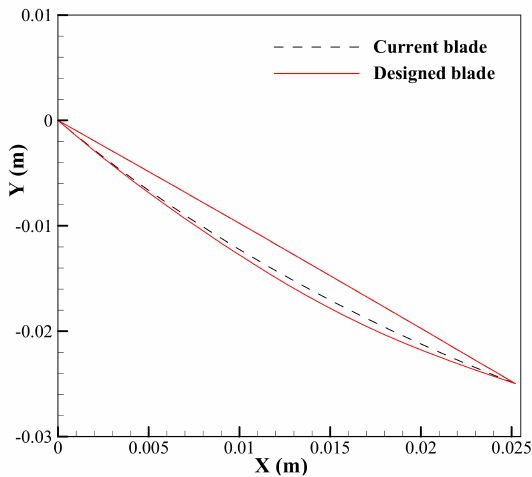
Figure 19. Comparison of current and designed transonic blade geometries blade by UESA with the spine constraint and E distribution